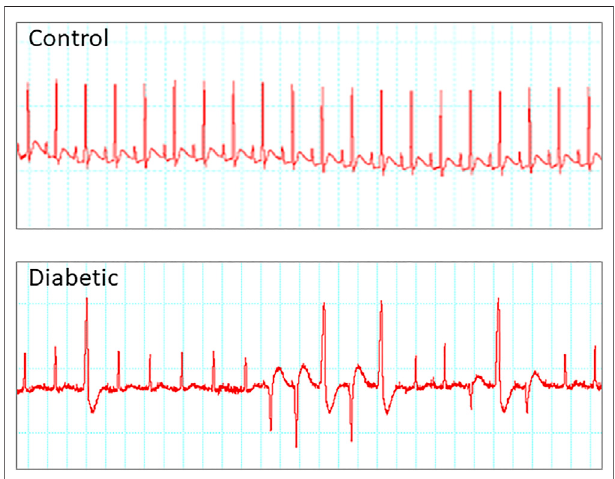
FIGURE 2 | Diabetes is a substrate for developing arrhythmia. Example of electrocardiograms recorded from control and type 2 diabetic rats upon stimulation with caffeine plus dobutamine. Only diabetic animals develop arrhythmia under cardiac challenge.